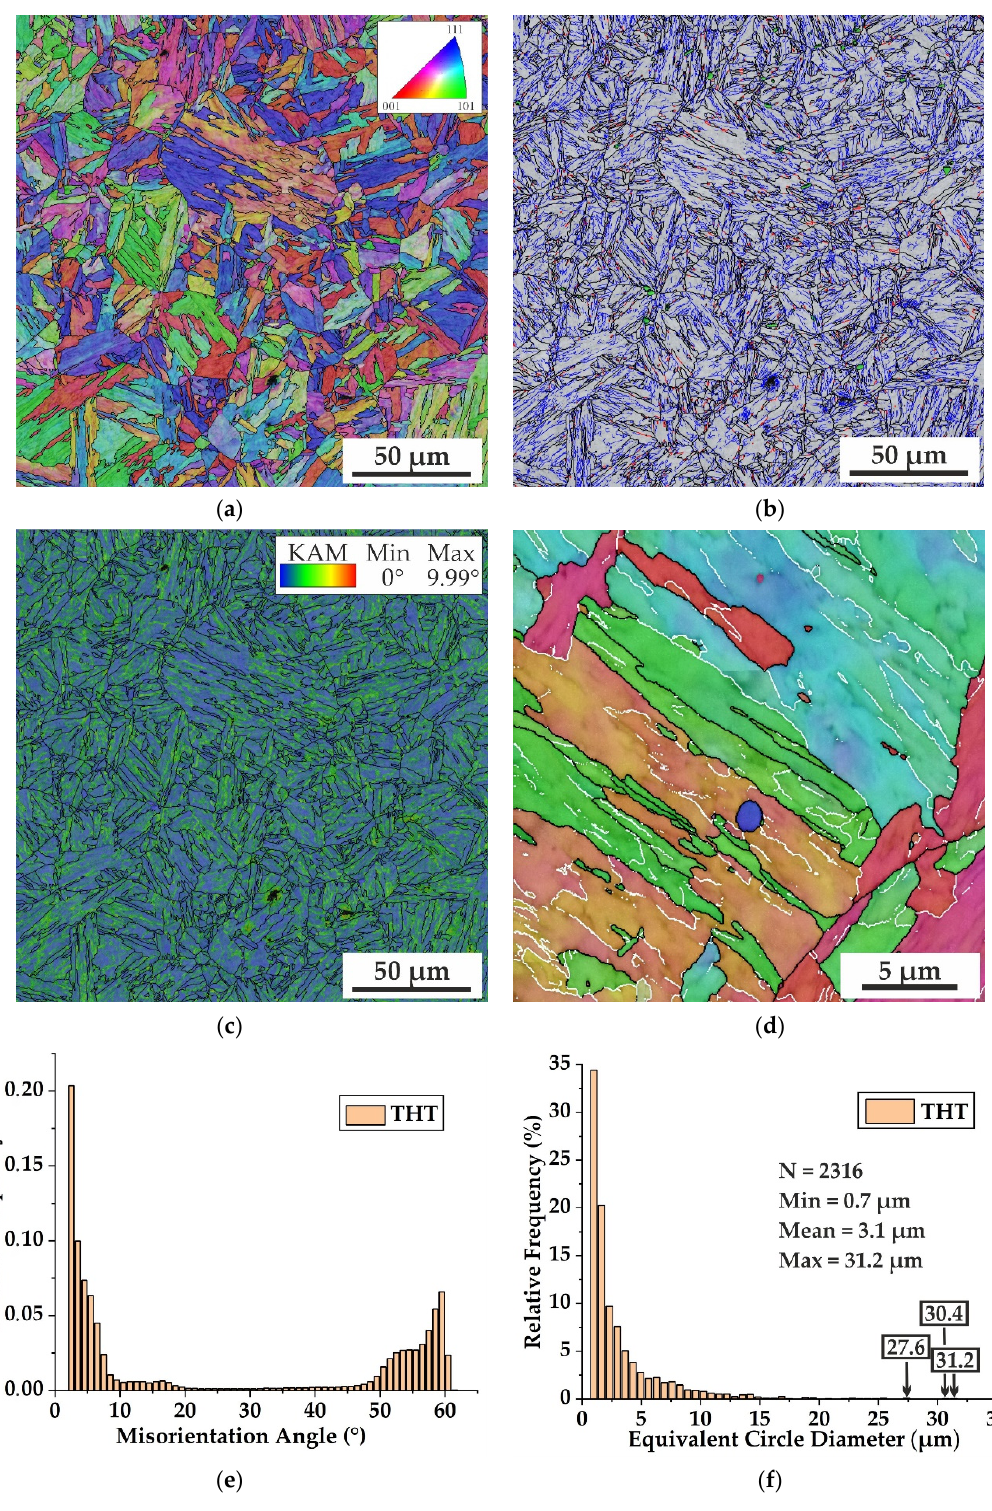
Figure 1. SEM EBSD images of steel microstructure after THT. Orientation map ( a ). Phase map, where MX particles are in green color, bcc-Fe is in gray color with high-, low-angle, and twin boundaries denoted by black, blue and red lines, respectively ( b ). Kernel Average Misorientation (KAM) map ( c ). Magnified orientation map with high-angle and low-angle boundaries denoted by black and white lines ( d ). Grain misorientation distribution ( e ). Histogram of grain size distribution ( f ). In the other figures, the same boundary coloring is